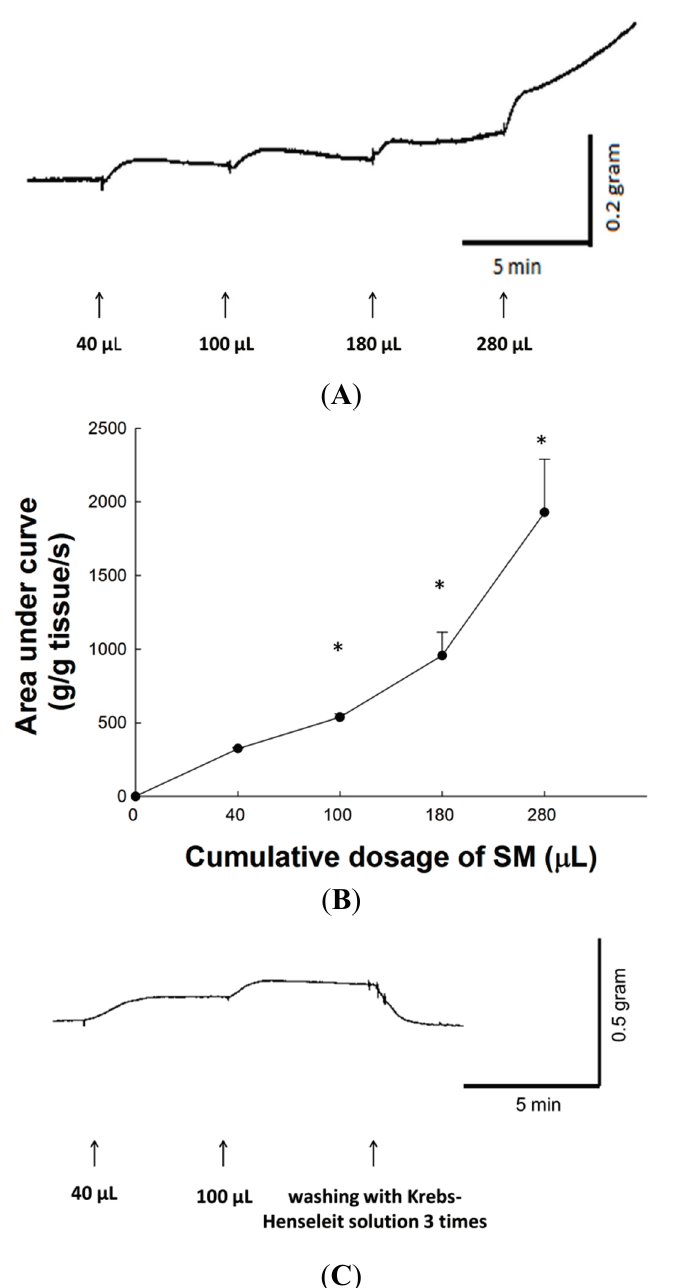
Figure 1. The SM extracts-induced contractions of LES in rat. ( A ) Typical tracing of the contraction of LES in rat in response to cumulative addition of SM extracts; ( B ) Concentration-response curves for the SM extracts-induced contractions of rat LES. Arrows indicate the addition of SM extracts on cumulative dosage at intervals of 5 min; ( C ) Contraction curve of LES returned to prestimulation level after removing SM extracts with Krebs-Henseleit solution. The contractile change was compared to resting contractility of corresponding experiments. * Significantly different from the resting contractility at p <